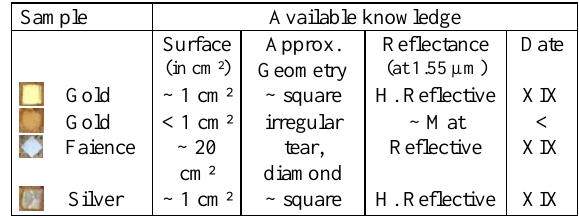
Table 1 Tesserae knowledge and semantic properties Finally, semantic information is transferred to the point cloud that can be used for information extraction (Figure 7).